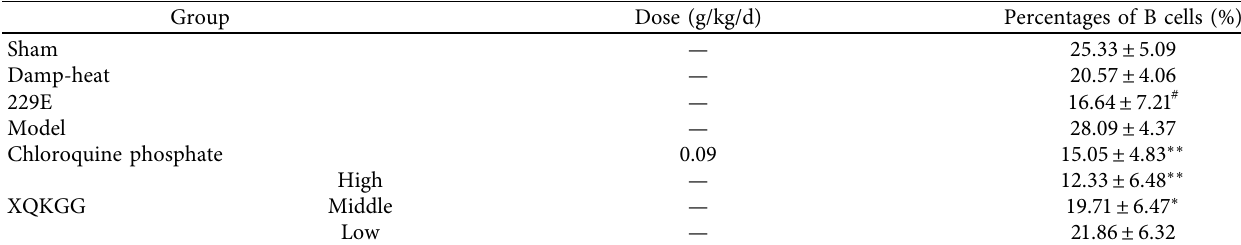
Table 3: Comparison of the percentages of immune cells in the blood in groups ( n � 6).